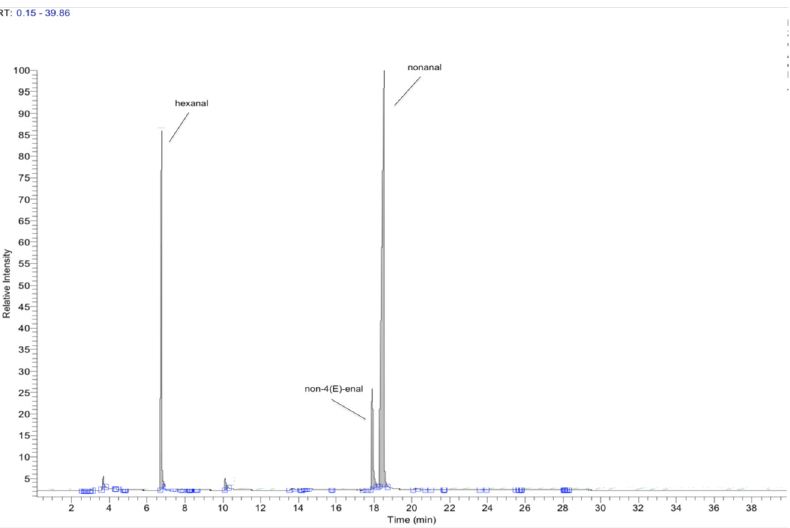
Figure 3. The results of HS-SPME and GC-MS analysis after olive oil ozonation (0.10 mole O 3 /100 g oil).